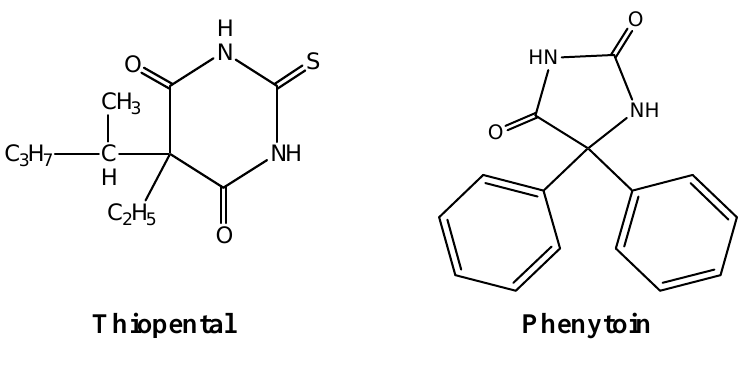
Figure 1. Chemical structure of lead (II)